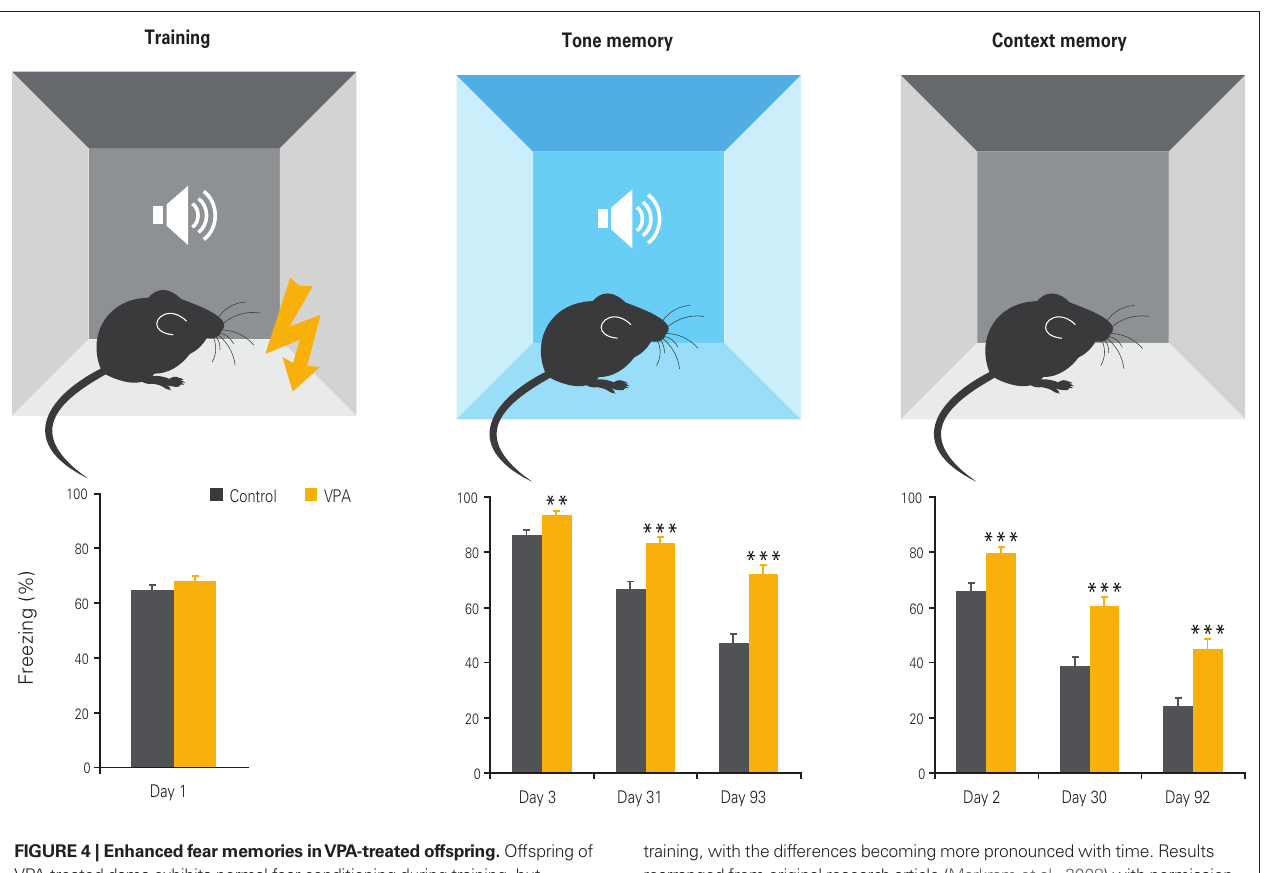
Figure 4 | enhanced fear memories in VPA-treated offspring. Offspring of VPA-treated dams exhibits normal fear conditioning during training, but enhanced fear memories to the tone and context 1, 30, and 90 days after